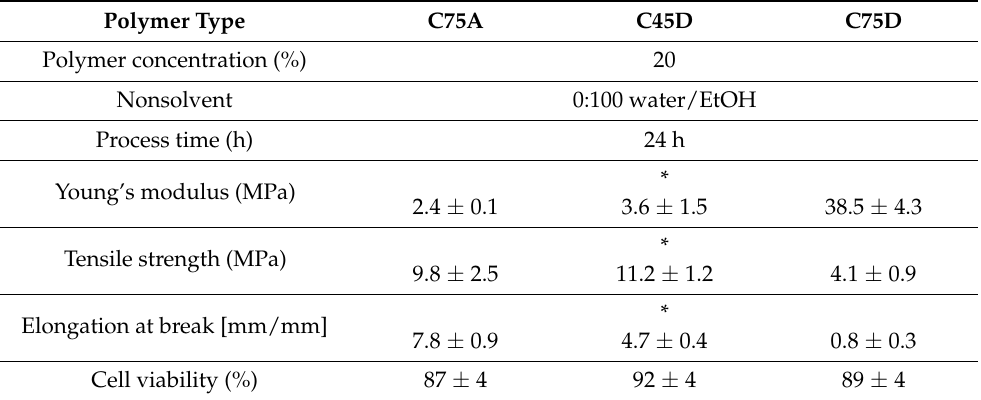
Table 4. Mechanical properties of C75A, C45D and C75D materials obtained with selected process parameters and cytotoxicity results ( n = 5).